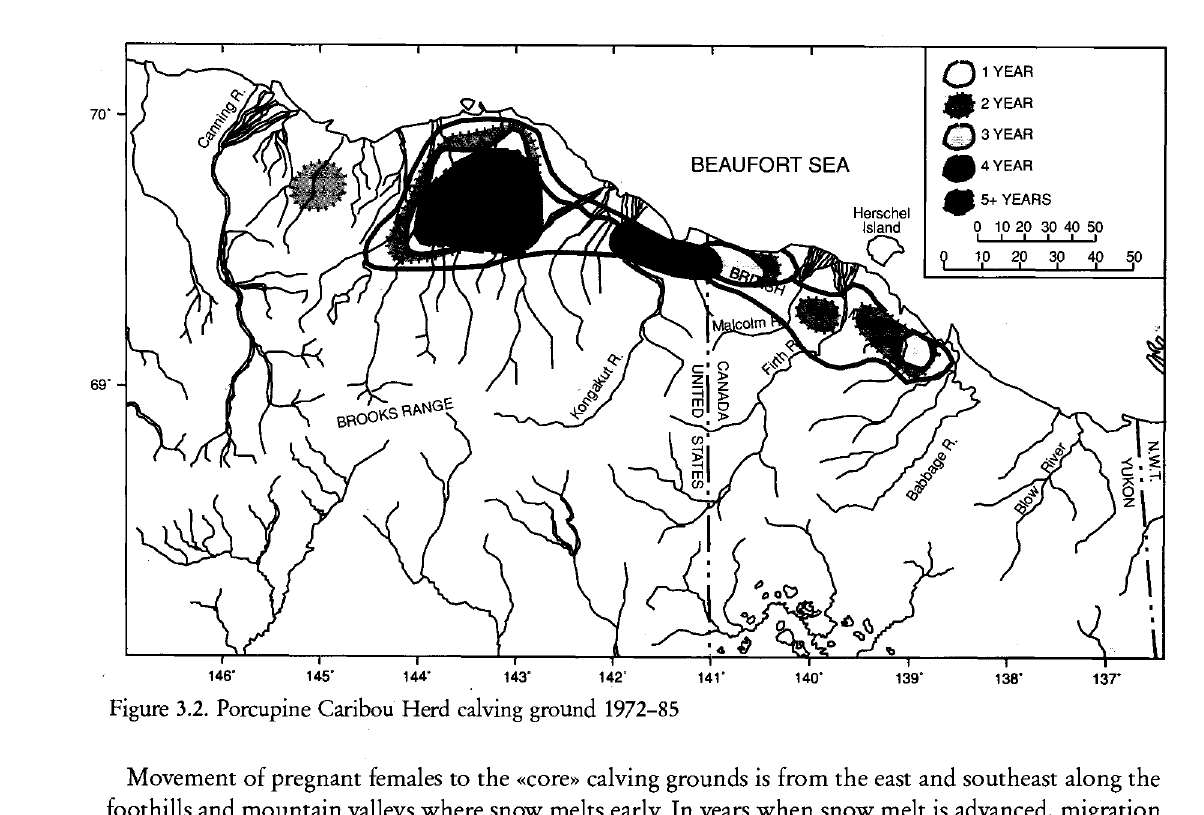
Figure 3.2. Porcupine Caribou Herd calving ground 1972-85 Movement of pregnant females to the «core» calving grounds is from the east and southeast along